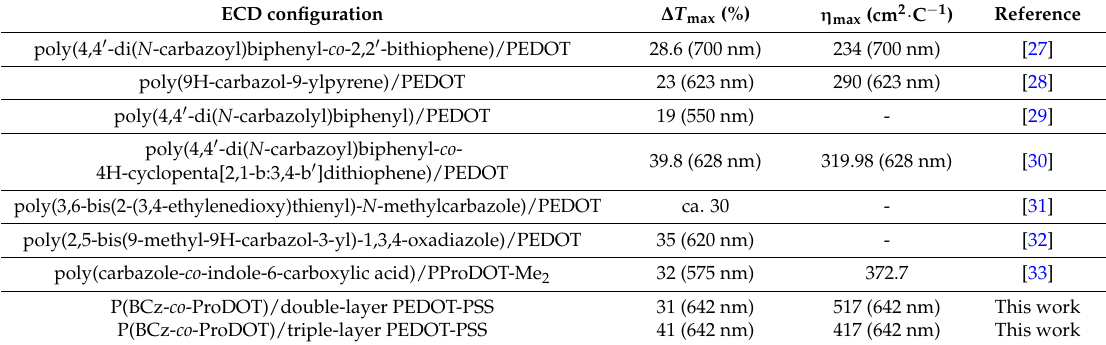
Table 4. Electrochemical optical contrast and coloration efficiencies of carbazole-group ECDs.